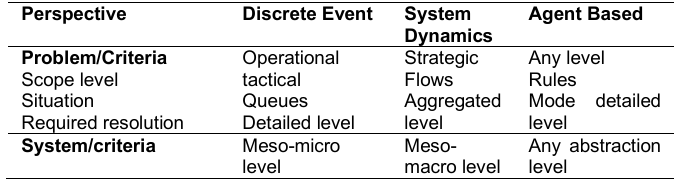
Table 3. Selection criteria of the simulation